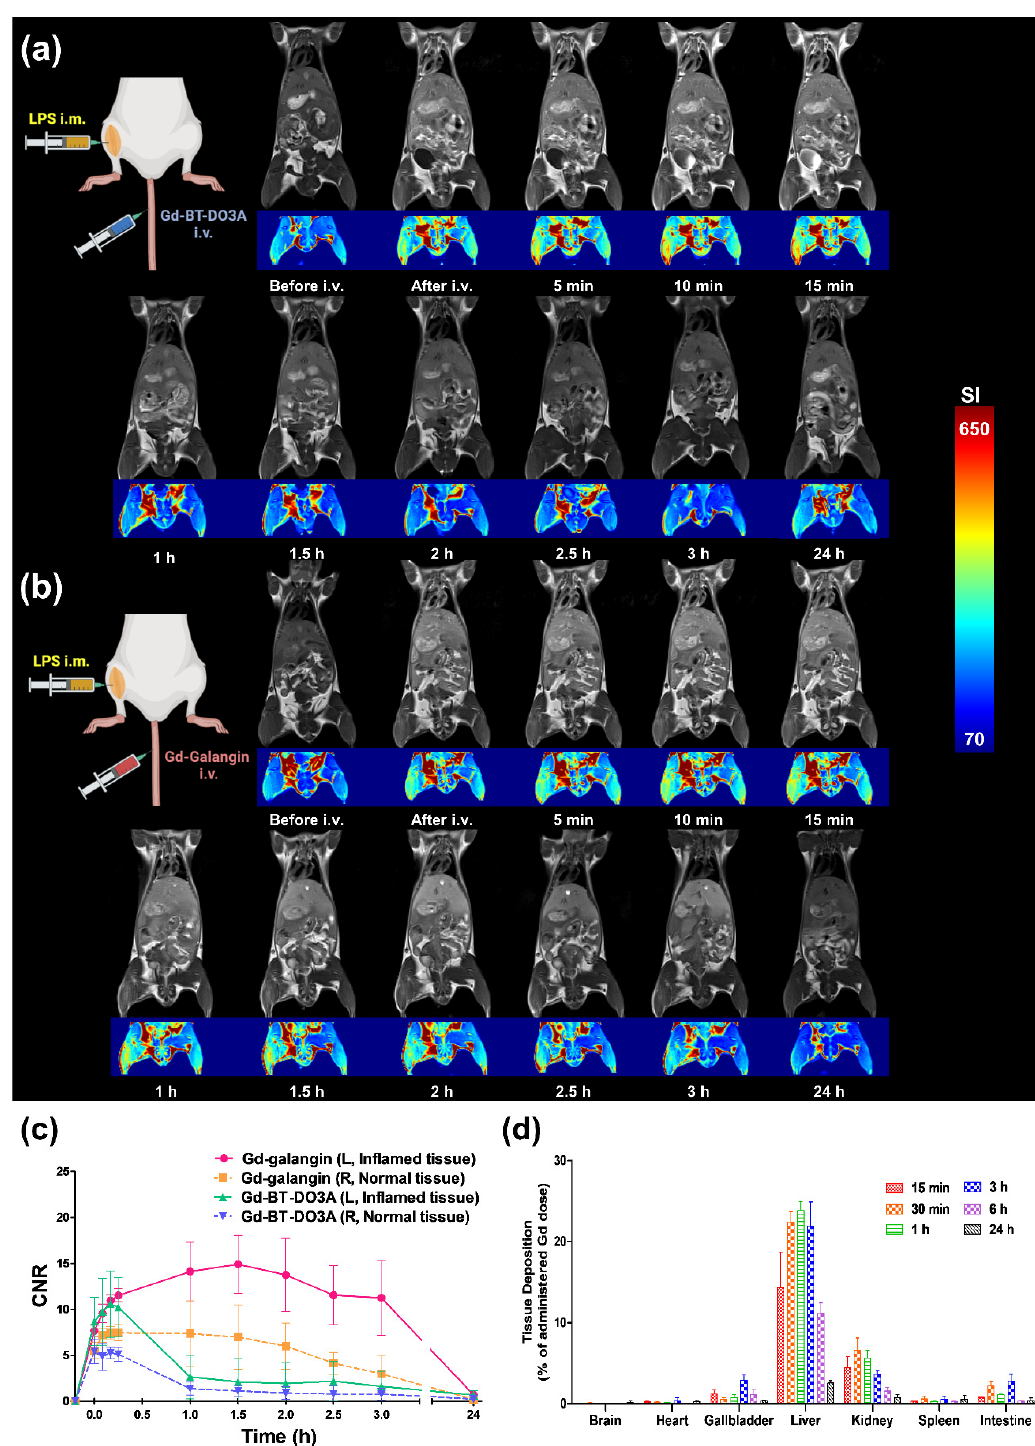
Figure 4. T 1 -weighted whole body magnetic resonance (MR) images of lipopolysaccharide (LPS)- induced inflammation animal model obtained after the intravenous injection of ( a ) Gd-BT-DO3A (Gadovist ® ) and ( b ) Gd-galangin, respectively (0.1 mmol Gd/kg, n = 3 for each group). ( c ) Contrast- to-ratio (CNR) of T 1 -weighted whole body MR images obtained after Gd-BT-DO3A (Gadovist ® ) and Gd-galangin intravenous injection ( n = 3). Normal tissue (right leg) and inflamed tissue (left leg). CNR was calculated using Equation (3). ( d ) Biodistribution of Gd-galangin (0.1 mmol Gd/kg) in normal BALB/c mice by Gd percentage in each tissue. Groups of mice ( n = 4) were sacrificed at 15 min, 30 min, 1 h, 3 h, 6 h and 24 h. Data are expressed as the mean ± SD.